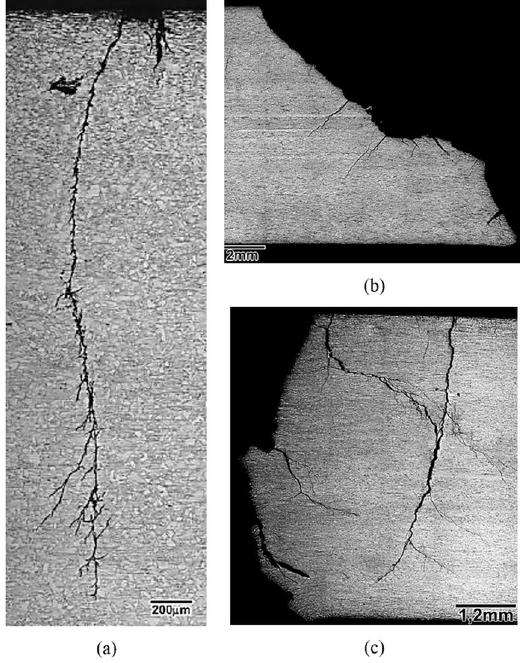
Figure 9. Metallographic examination of the crack propagation, cross section after DET at 110 °C. (a) UNS S31603 ASS tested at 50 % of the yield stress (139 MPa); (b) UNS S32205 DSS tested at 100 % of the yield stress (473 MPa); (c) UNS S32750 SDSS tested at 100 % of the yield stress (589 MPa). Optical